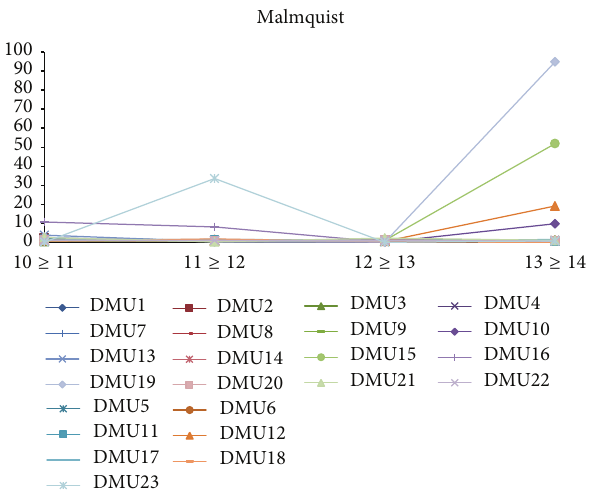
Figure 3: Productivity index (MPI) change over the period 2010 to